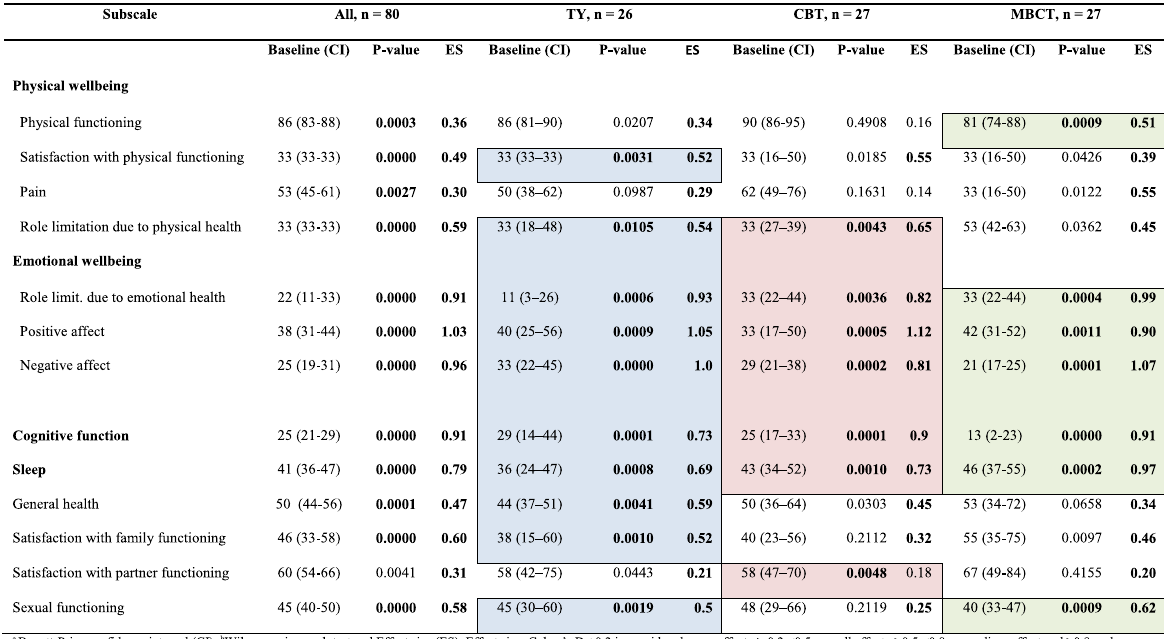
Table 6 SWED-QUAL baseline median subscale scores ranging from 0(worst) to 100(best possible) a , and test of treatment effect b per group and for all. Main results marked